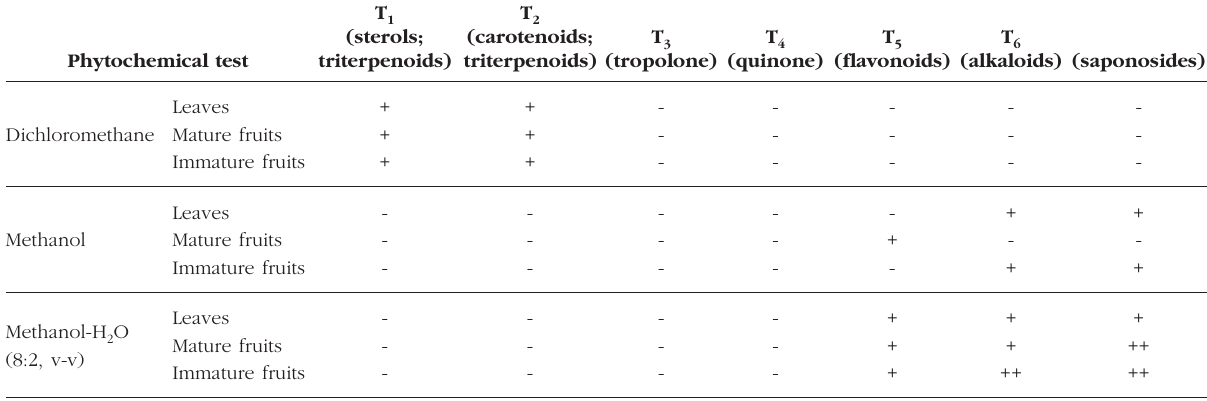
Table II. – Chemical groups present in the extracts from aerial parts of Solanum nigrum var. villosum .